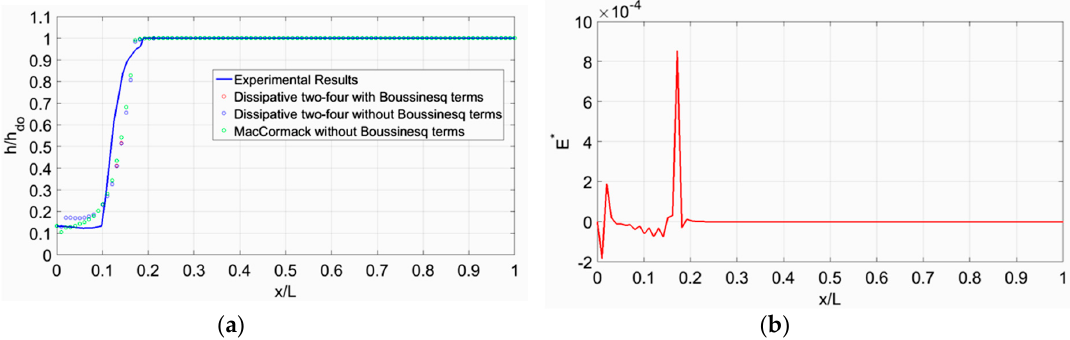
term versus distance.